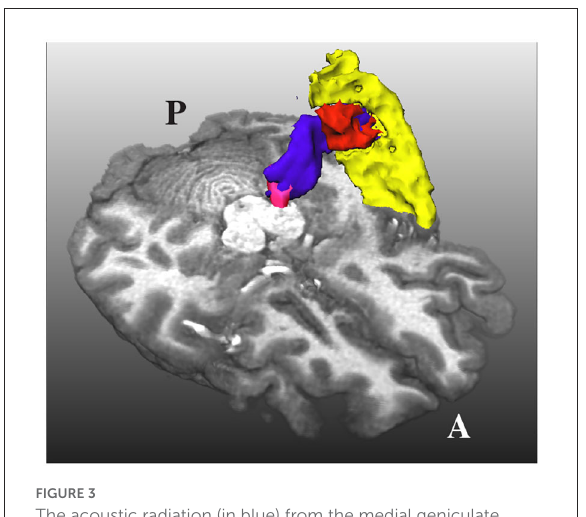
FIGURE3 The acoustic radiation (in blue) from the medial geniculate nucleus (in magenta) and the Heschl’s gyrus (in red) is also very close to the superior temporal gyrus (in yellow). A and P indicate the anterior and posterior sides of the brain, and T1w is used as a